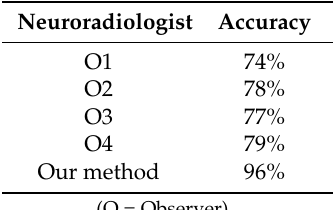
Table 8. Comparison to human reported